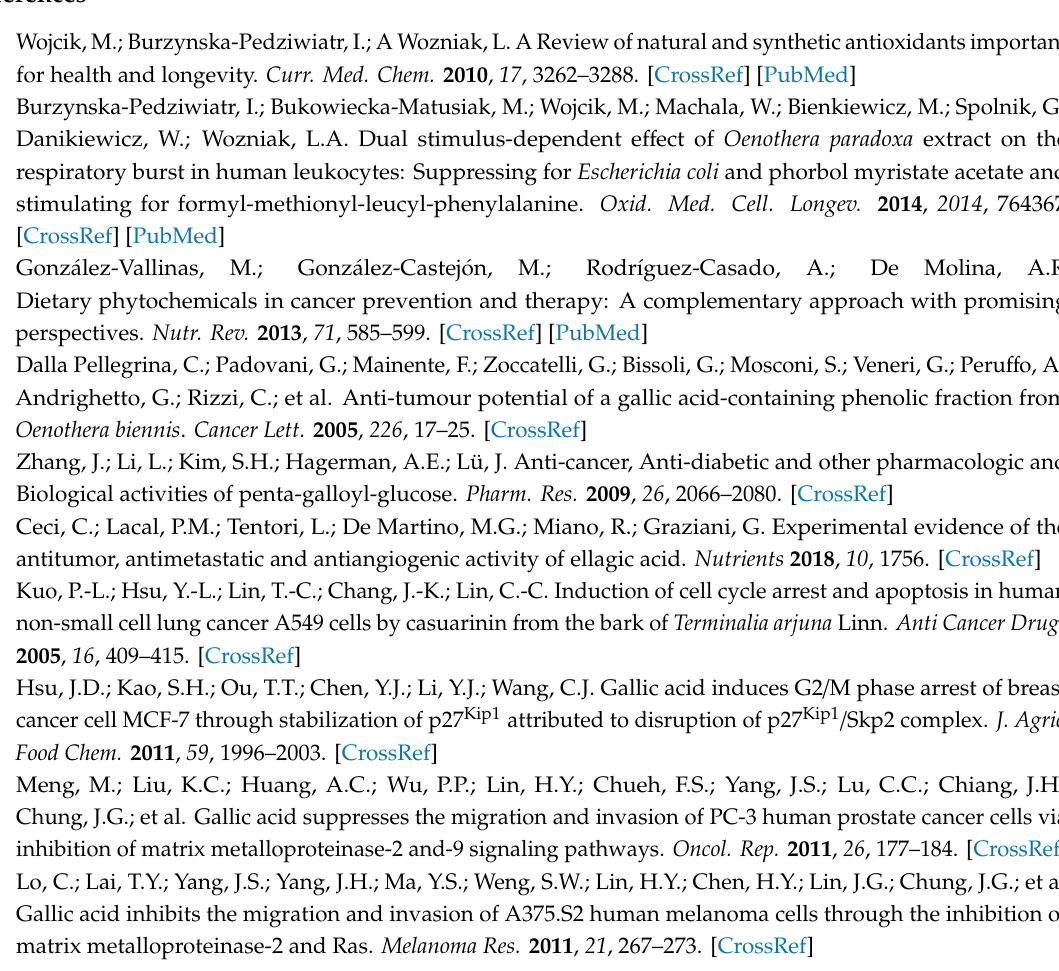
Figure S1: Qualitative LC TripleTOF MS 4600 profile of EPE 24 performed in negative ionization mode, Figure S2: TripleTOF 4600 MS / MS product ions of particular compounds determined in EPE24 performed in negative ionization mode. Figure S3: LC-TripleTOF-MS 5600 + spectra of the selected compounds of O . paradoxa